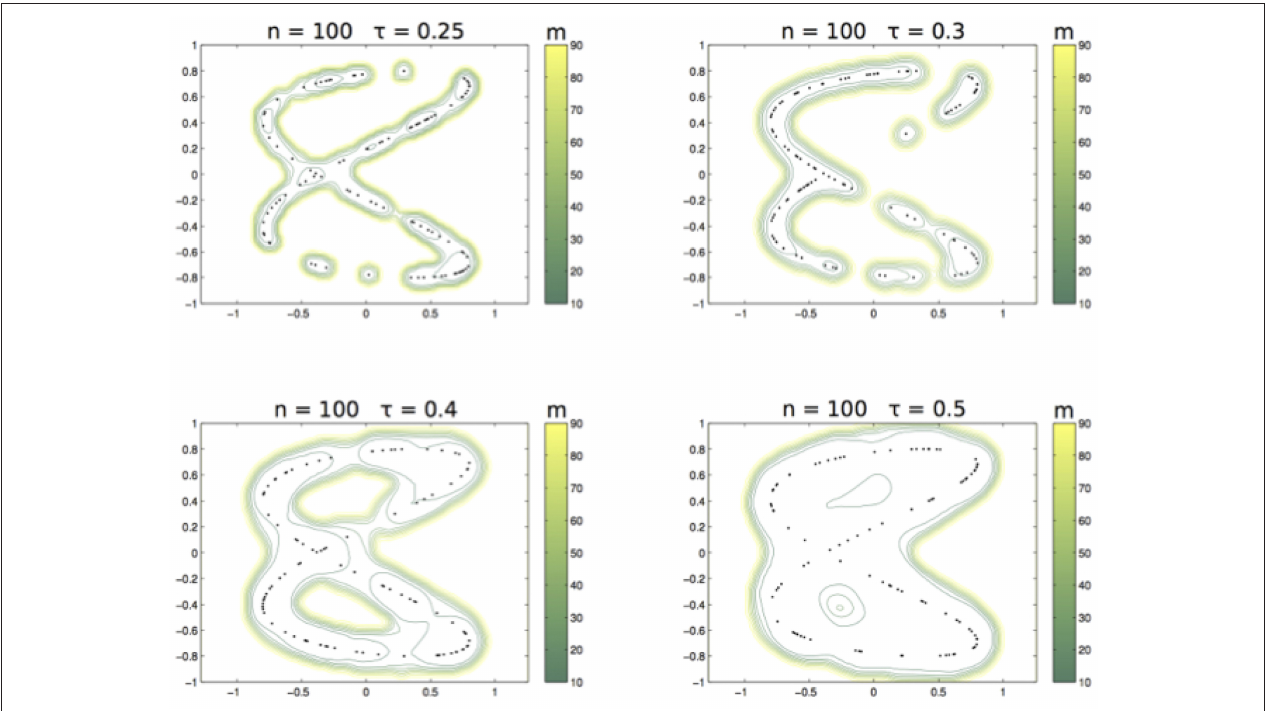
FIGURE 7 | From left to right and top to bottom: The family of sets ˆ C m ,0.25 100 , ˆ C m ,0.3 100 , ˆ C m ,0.4 100 , ˆ C m ,0.5 100 with m varying as in the related colorbar.